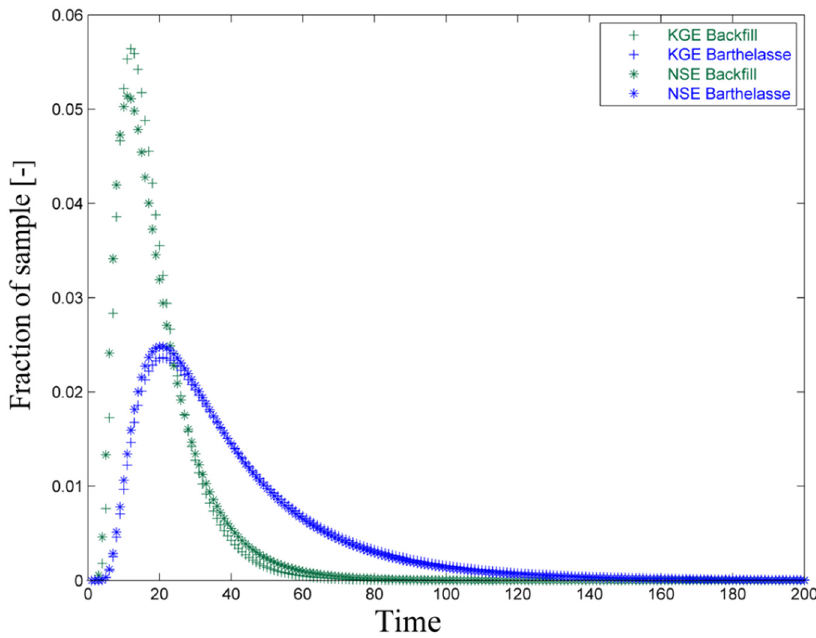
Figure 11. Distribution of transit times within the backfill and the Barthelasse on a flood scale. The reconstruction of the isotopic curve for the Barthelasse well is better than for the backfill (Figure 12). Indeed, in the first few days at the backfill, a rapid decrease followed by a rapid increase in the value in δ 18 O was visible, but the models failed to reconstruct it correctly.